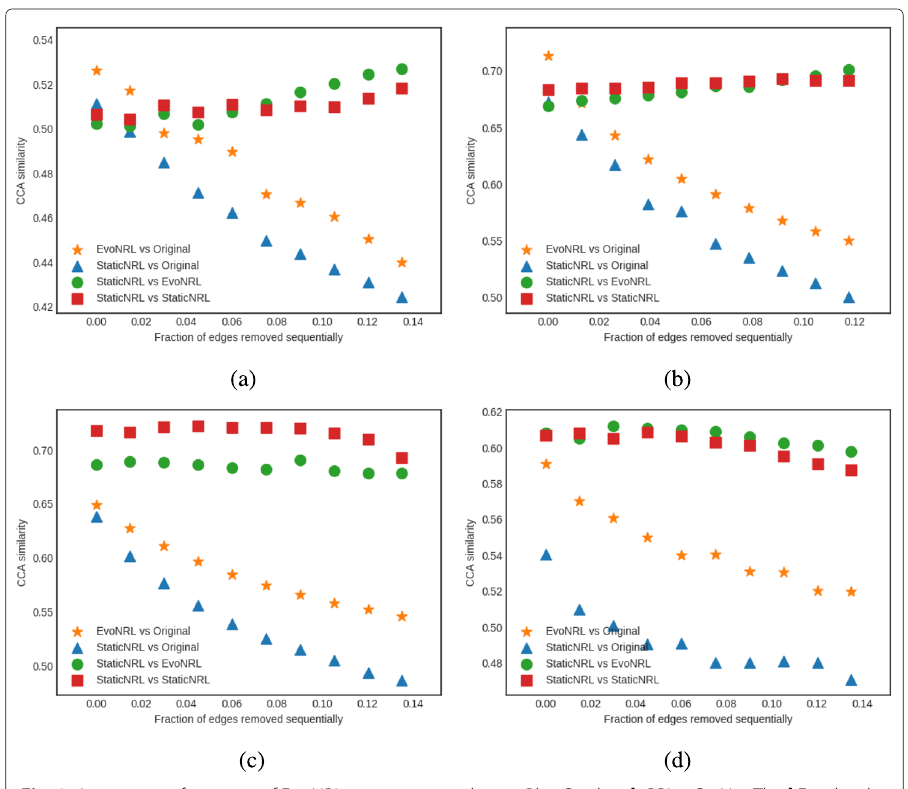
Fig. 8 Accuracy performance of E VO NRL — removing edges. a BlogCatalog, b PPI, c Cit-HepTh, d Facebook